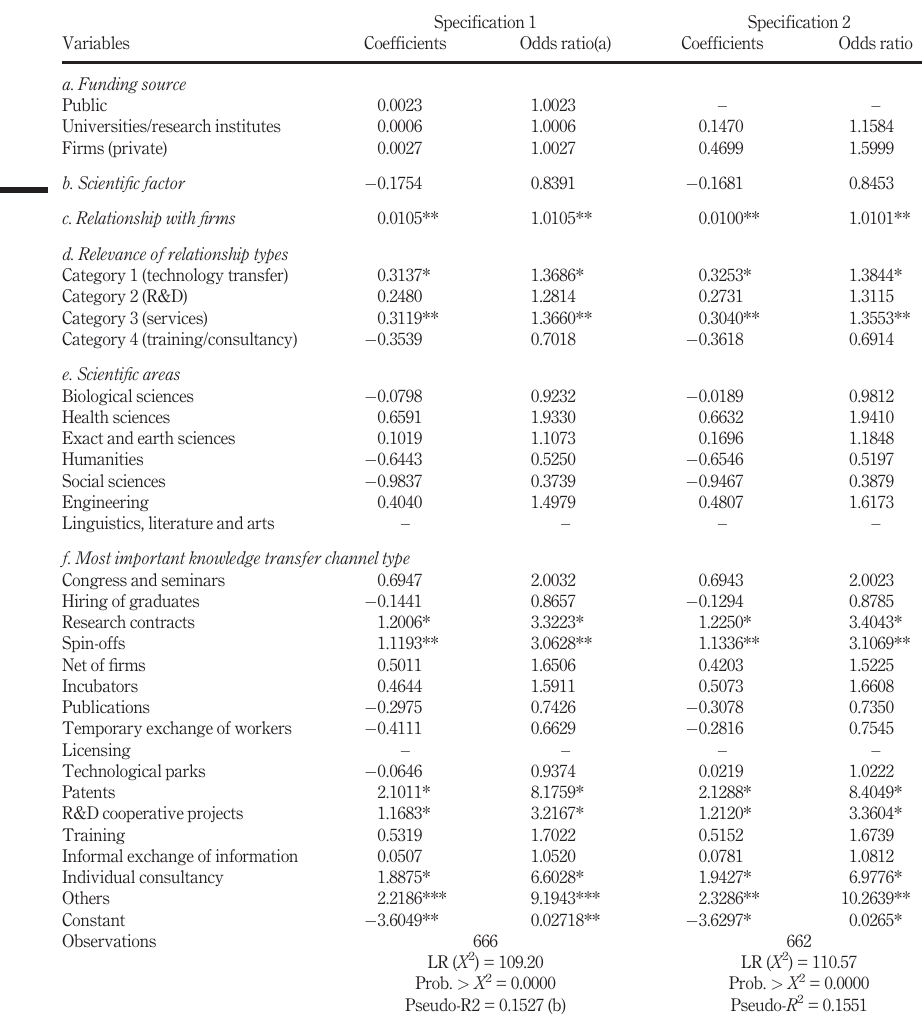
Table VII. Logit model results